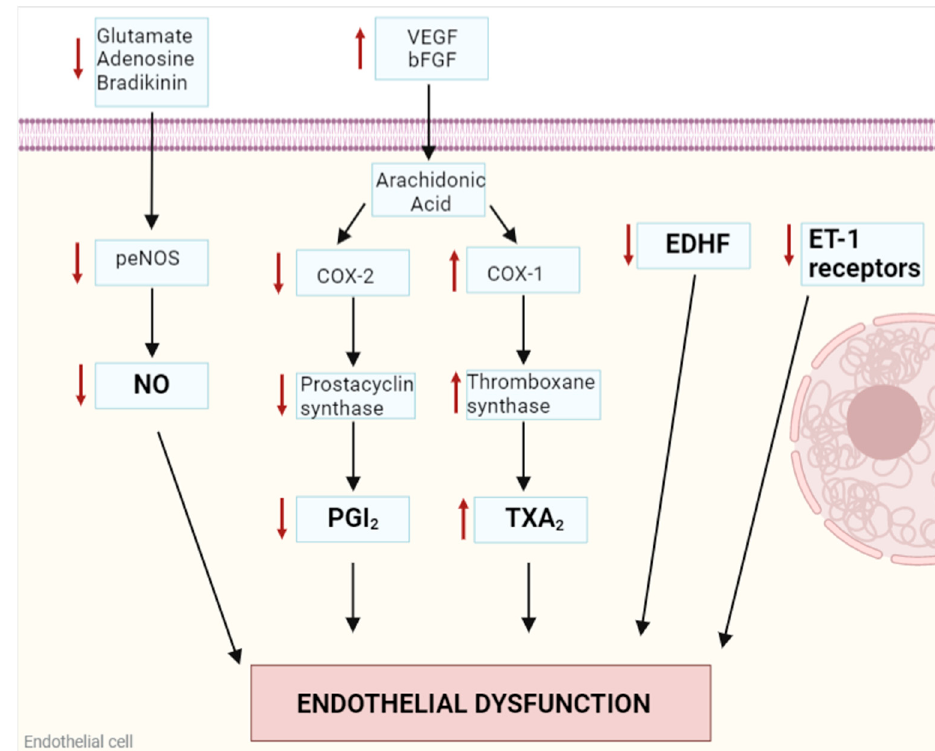
Figure 1. Endothelial dysfunction is regulated by different autocrine and paracrine factors released by endothelial cells. Different mediators are involved in the impairment of the vasoconstriction/vasodilation modulation: inhibition of eNOS through its dephosphorylation at Ser1177, which reduces NO release from ECs; downregulation of COX-2 and prostacyclin synthase, which are involved in PGI 2 synthesis from arachidonic acid; upregulation of COX-1 and thromboxane synthase, which increase TXA 2 ; and a decrease in EDHF release and reduction in ET-1 receptors on EC membranes are all factors that contribute to the contraction of the vessel walls. eNOS: endothelial nitric oxide synthase; NO: nitric oxide; EC: endothelial cells; VEGF: vascular endothelial growth factor; bFGF: basic fibroblast growth factor; COX: cyclooxygenase; PGI 2 : prostacyclin; TXA 2 : thromboxane A 2 ; EDHF: endothelium-derived hyperpolarizing factor; ET-1: endothelin-1. Image created with Biorender.com.